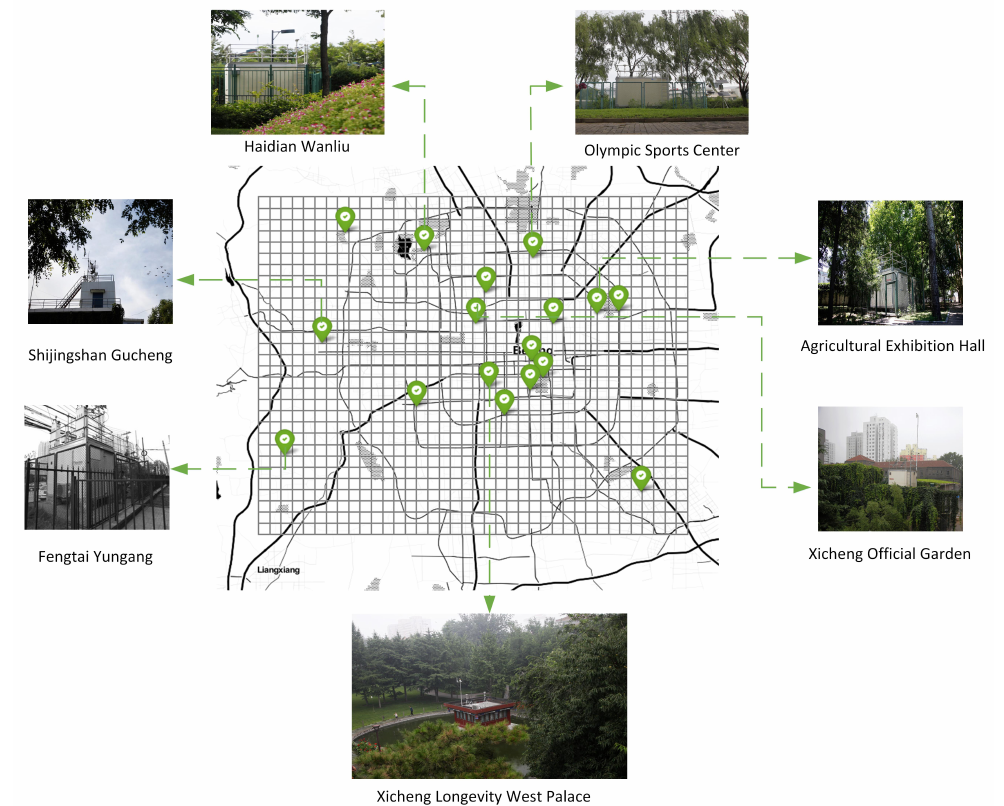
Figure 3. Division of urban areas based on geographic